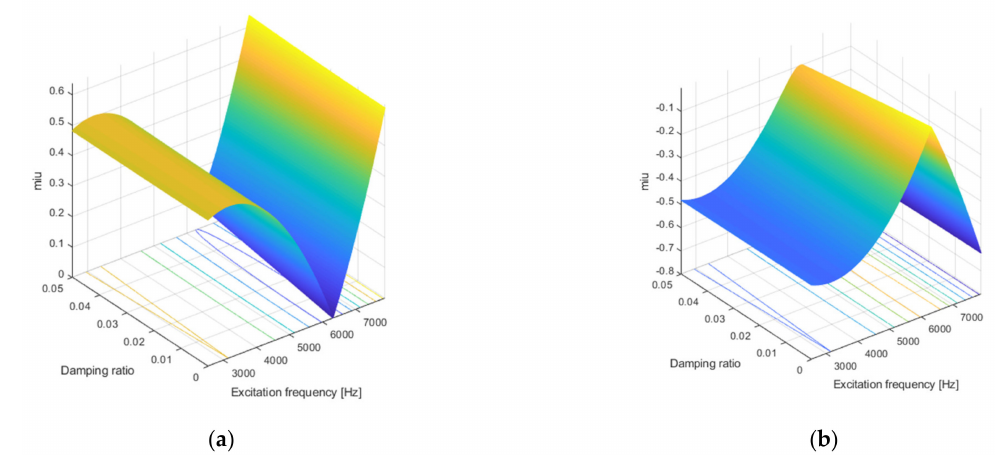
Figure 20. Stationary dynamic instability surface frontier for the bowl. ( a ) µ > 0. ( b ) µ < 0.